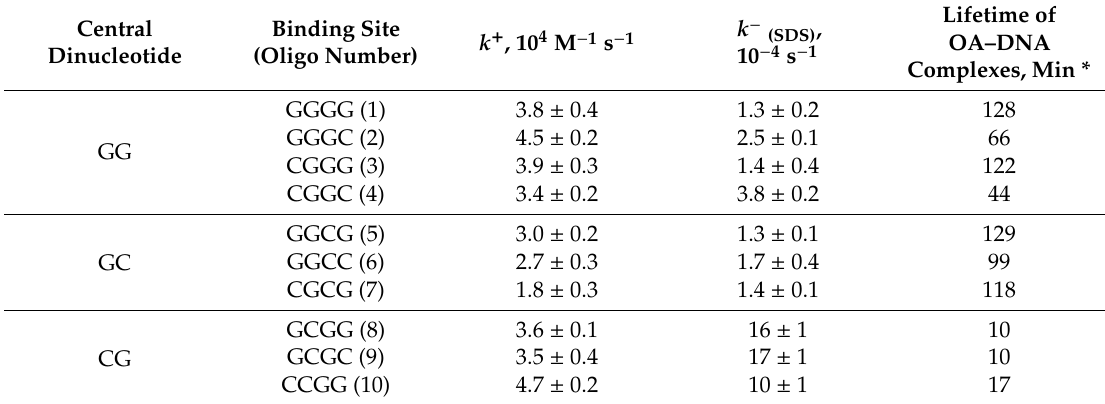
Table 2. Parameters of OA binding and dissociation for ten G / C sites.